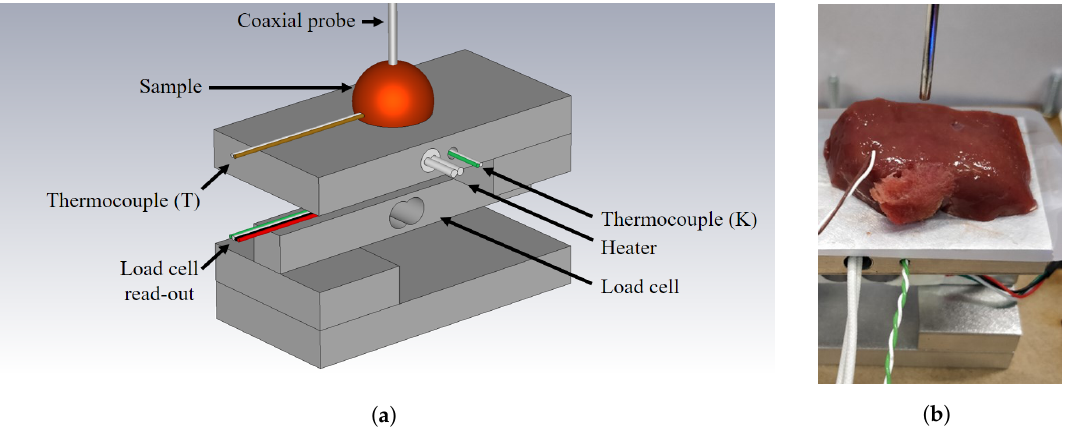
Figure 1. ( a ) Schematic overview of the used measurement setup with labeled components (note: the heater and thermocouple type K are not used in this work). ( b ) Photograph of the used measurement setup when a sample is loaded before the actual